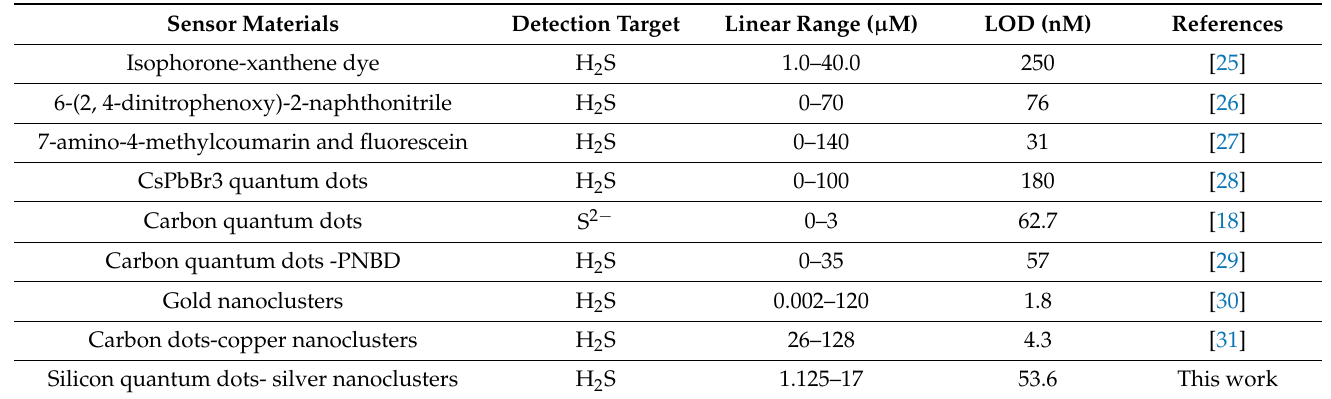
Table 1. Comparison of previously reported fluorescent sensors and SiQD-AgNC in this work.